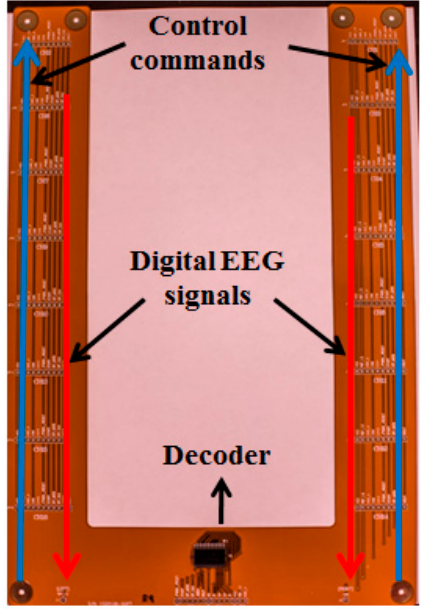
Figure 5. Top view of the flexible printed circuit board (FPCB). The red arrows indicate the direction of the digital electroencephalography (EEG) signals, and the blue arrows indicate the direction of the control commands.